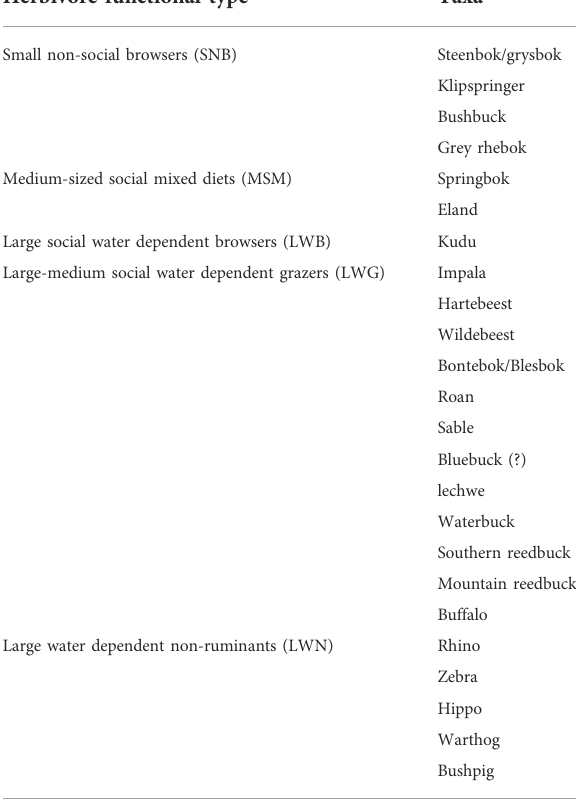
TABLE 1 Herbivore functional groups at Klasies River based on Hempson et al.